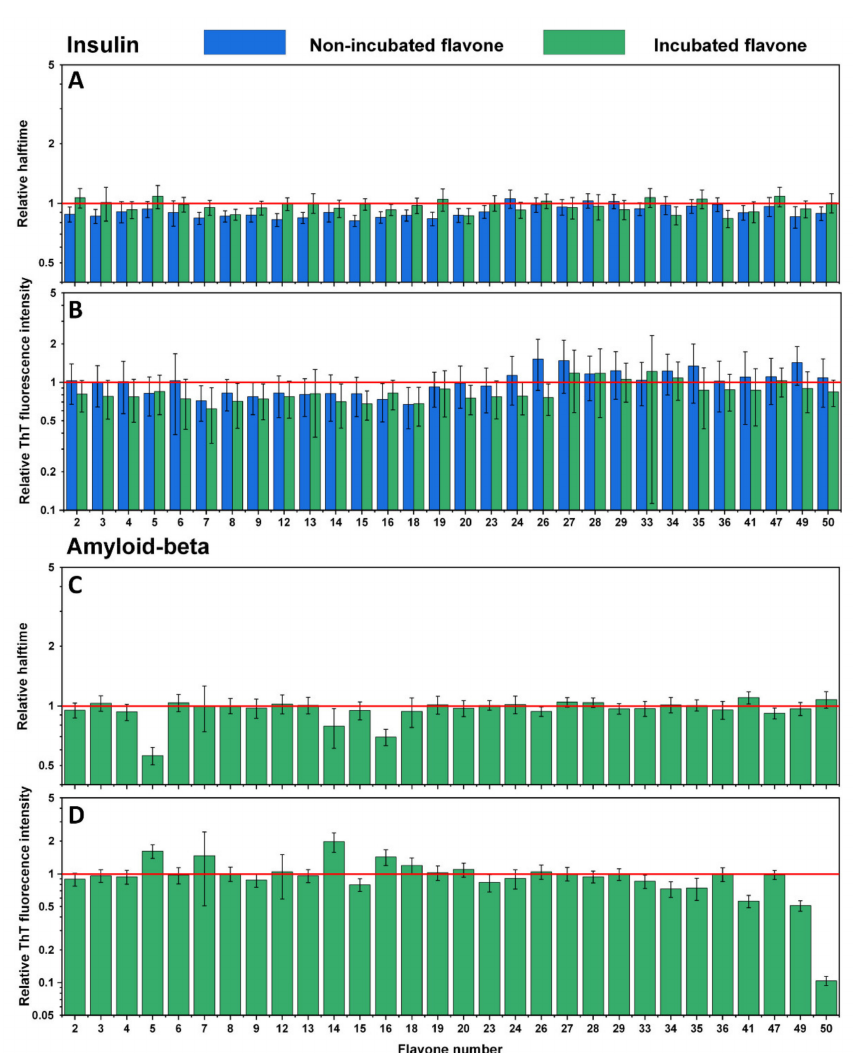
Figure 4. Effects of non-incubated and incubated flavones on insulin aggregation kinetics ( A ) and relative ThT fluorescence intensity ( B ). Effect of incubated flavones on A β 42 aggregation kinetics ( C ) and relative ThT fluorescence intensity ( D ). Error bars are for one standard deviation ( n = 4). The non-incubated and incubated flavones did not impact insulin and A β 42 relative halftime, while incubated flavones 34, 35, 41, and 50 had the most significant impact on the relative ThT fluorescence intensity of A β 42